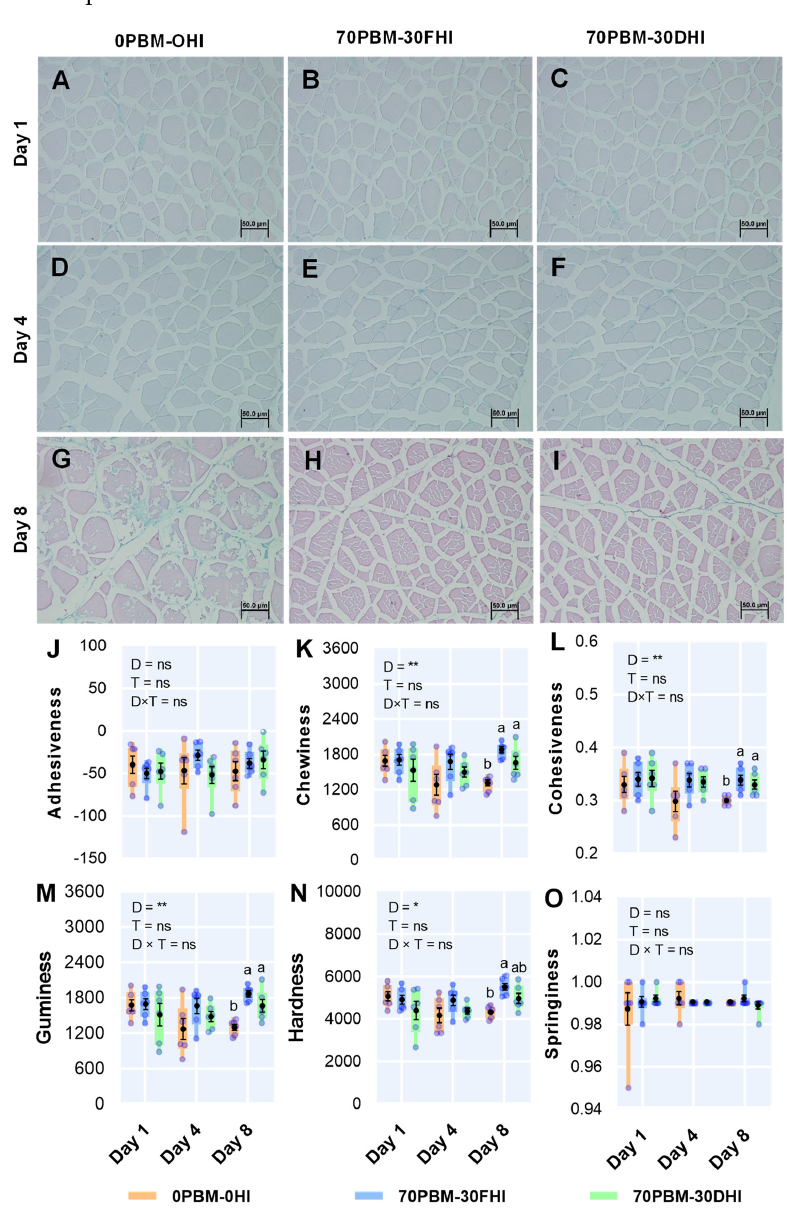
Figure 1. Representative muscle histology results at day 1 ( A – C ), day 4 ( D – F ), and day 8 ( G – I ) of fillets being stored at 4 ◦ C and changes in the fillet texture profiles, including adhesiveness ( J ), chewiness ( K ), cohesiveness ( L ), gumminess ( M ), hardness ( N ), and springiness ( O ), for barramundi fed complete replacement of fishmeal (FM) diets with mixtures of poultry by-product meal (PBM), full-fat Hermetia illucens (FHI), and partially defatted Hermetia illucens (DHI) larvae meal. The semi-transparent light blue round markers indicate individual datapoints ( n = 6), while the box–whisker plot of individual datapoints and black marker denote the mean and standard error values, respectively. Lower cases in the figure indicate significant differences between the treatments. The asterisks represent the significant differences at * p < 0.05, and ** p < 0.01; ns denotes